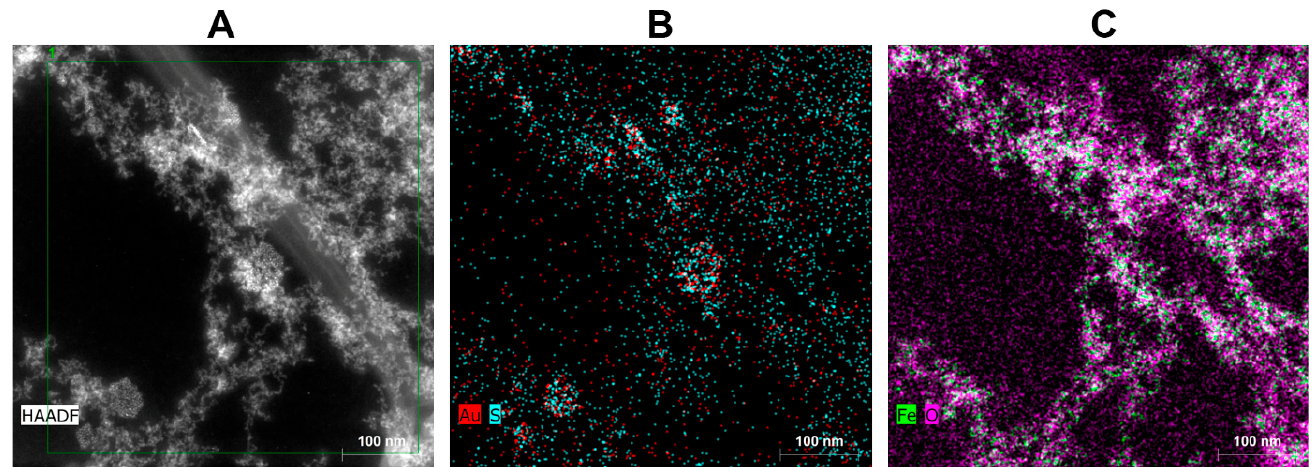
Figure 3. Scanning transmission electron microscopy (STEM) and energy dispersive spectroscopic (EDS) analysis of a representative AuBSA-Fe sample: ( A ) STEM image, scale bar of 100 nm; ( B ) Au and S spatial distribution map; and ( C ) Fe and O spatial distribution map. Table 1. Hydrodynamic diameter (represented by Z-average) and polydispersity (PDI) of nanocom- posites determined by DLS measurements.